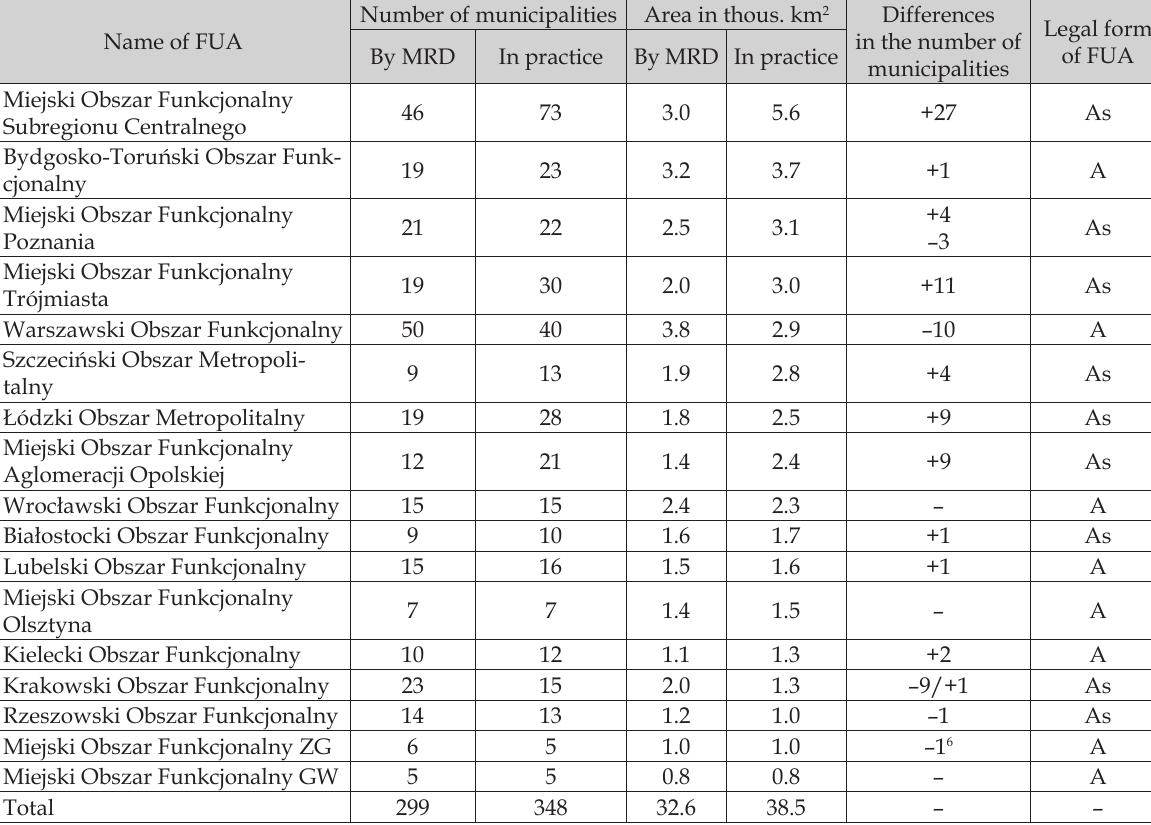
Table 1. Size of functional urban areas by the MRD delimitation and in the practice of the ITI implementation. Name of